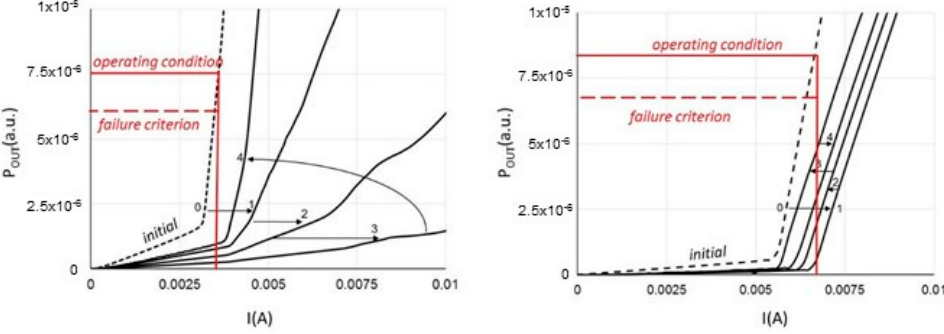
Figure 18. The LI curves of two different commercial laser diodes after proton irradiation